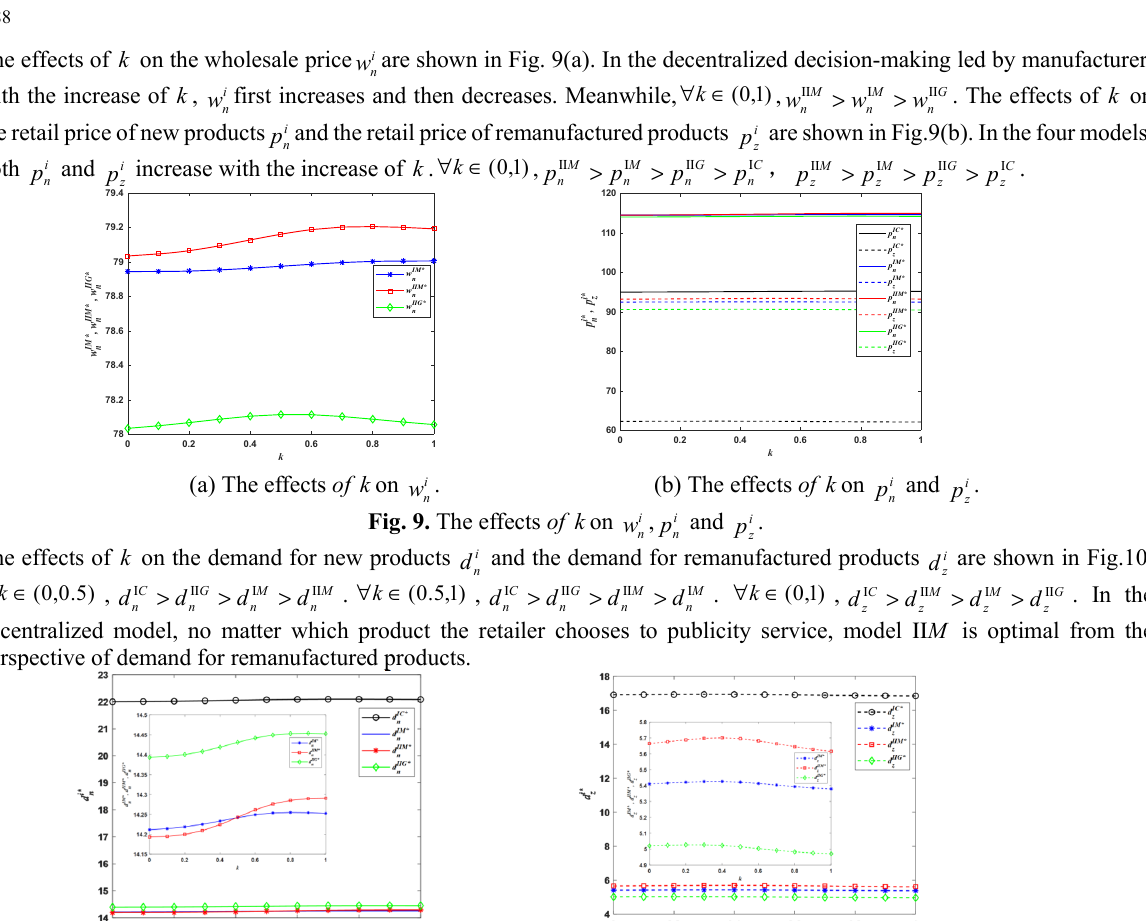
Fig. 10. The effects of k on i